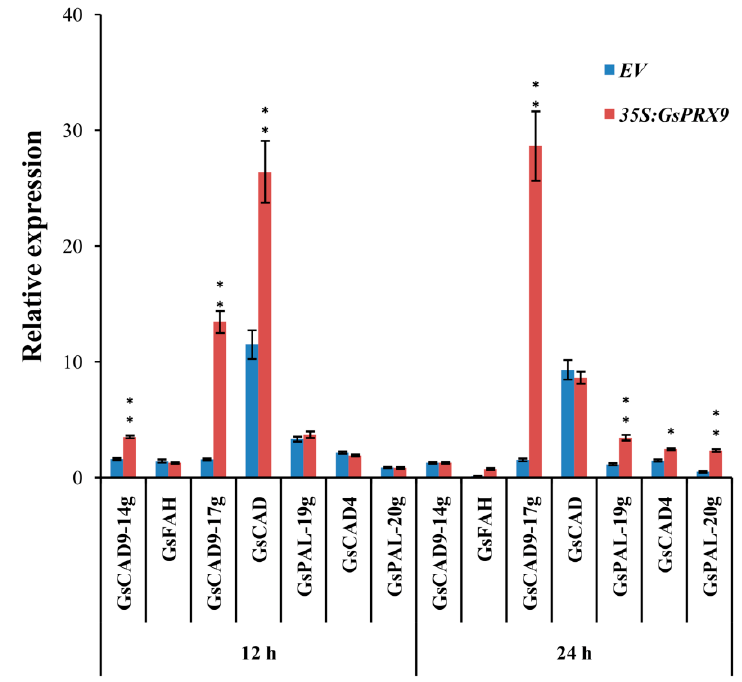
Figure 7. Relative expression of genes encoding potential GsPRX9-interacting proteins in soybean hairy roots. Root samples receiving 0 mM NaCl treatment at each time point were used as controls. Data represent mean ± standard deviation of four biological replications with three repeats within each replication ( n = 4 × 3 = 12). EV represents soybean hairy roots with the empty vector pBinGFP4, and 35S:GsPRX9 represents roots with the recombinant vector pBinGFP4– GsPRX9 ( GsPRX9 was expressed in fusion with GFP, driven by a CaMV 35S promoter). * and ** represents significant di ff erence between EV and 35S:GsPRX9 for each time point at the 0.05 or 0.01 level by Student’s t -test, respectively.